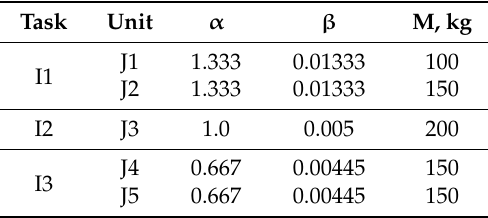
Figure 8. Recipe network for Example 3.